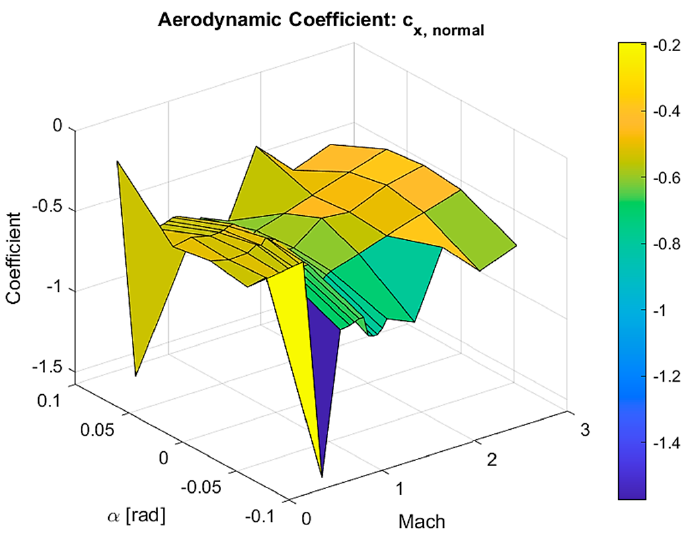
Figure 15. Axial drag coefficient as derived from the angle of attack and Mach number.